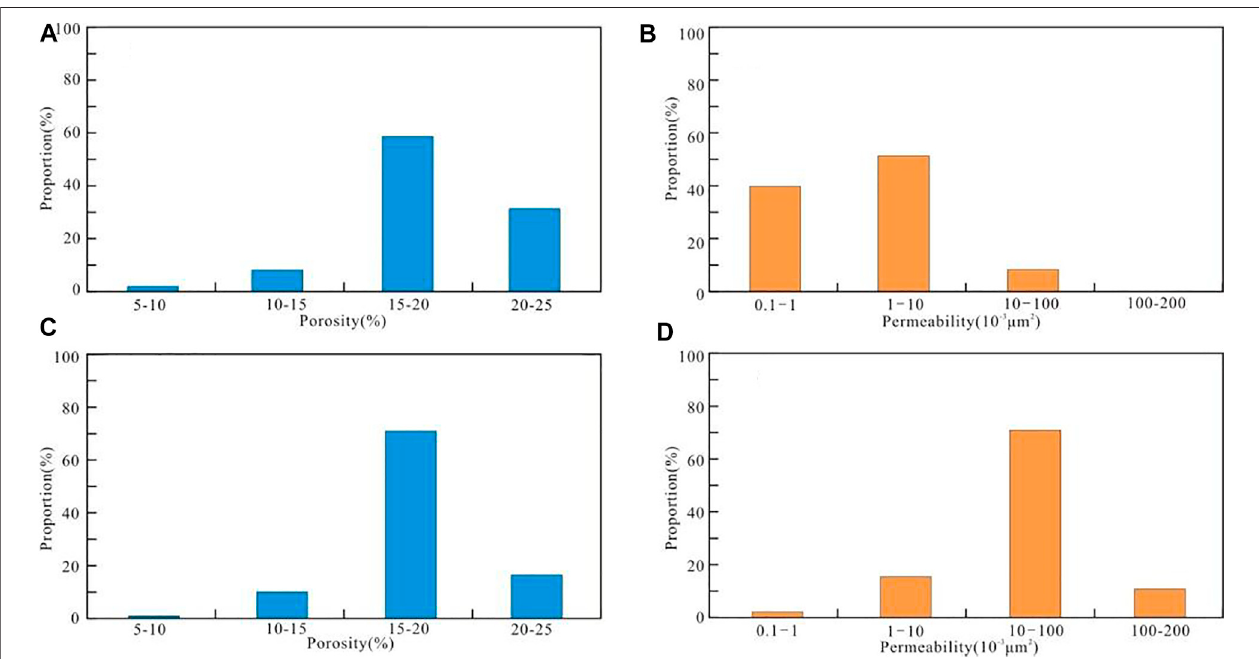
FIGURE3| Distributioncharacteristicsof (A) theporosityintheAF-1area, (B) permeabilityintheAF-1area, (C) porosityintheAF-2area,and (D) permeabilityinthe AF-2 area in the Huangliu sandstones.